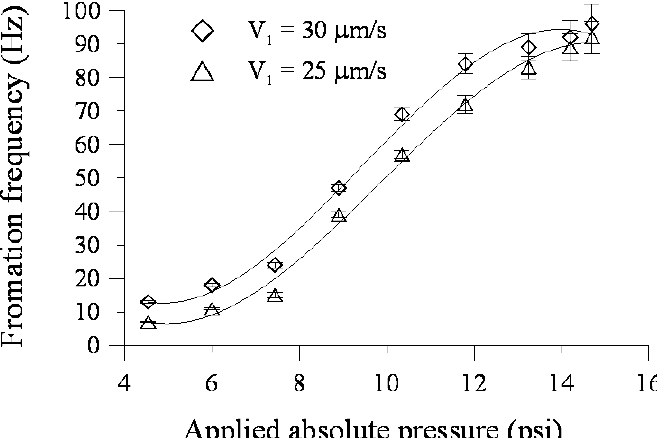
is constant at 50 2